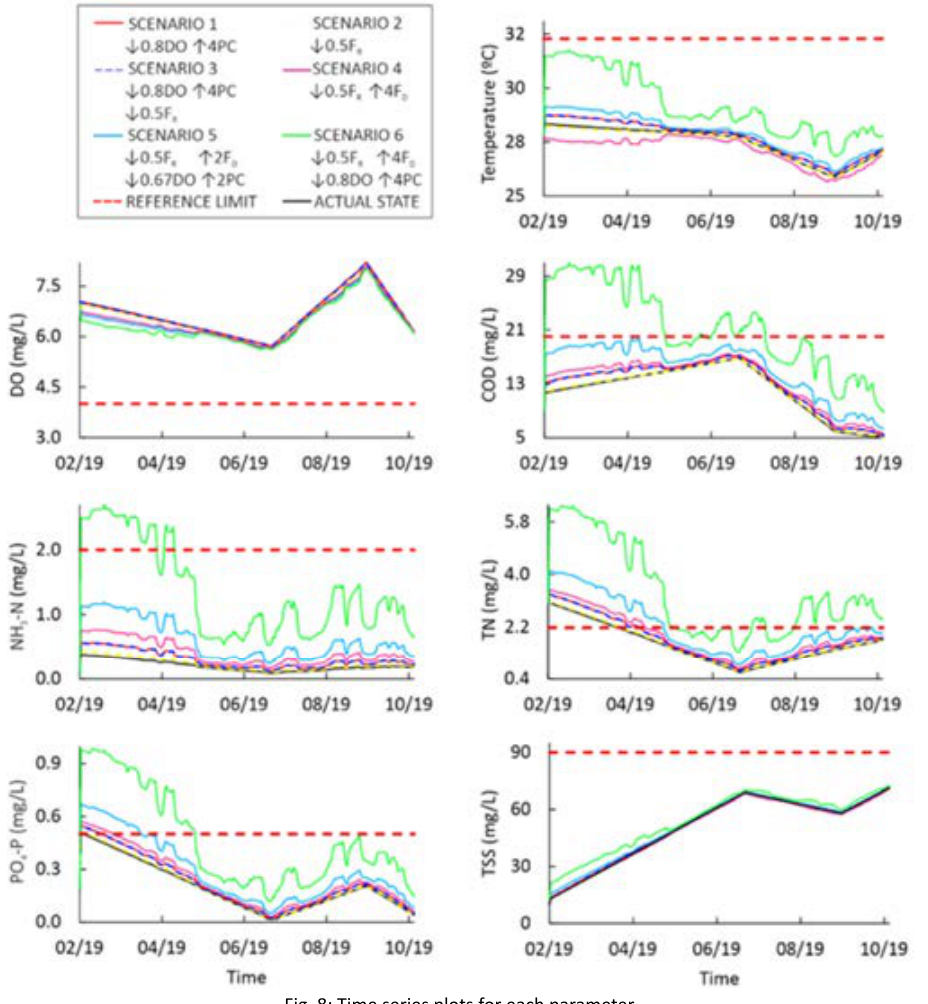
Fig. 8: Time series plots for each parameter